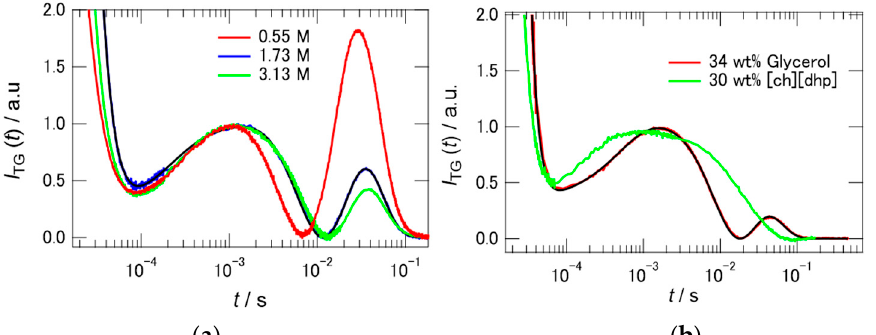
Figure 6. ( a ) TG signals of PYP in corresponding molar concentration of NaCl to 10, 30, 50 wt% [ch][dhp] solution. The q 2 values are 5.49 × 10 11 (0.55 M), 4.16 × 10 11 (1.73 M), and 4.92 × 10 11 (3.13 M) m − 2 . ( b ) Comparison of the TG signals between in the 34 wt% glycerol solution ( q 2 = 6.90 × 10 11 m − 2 ) and in the 30 wt% [ch][dhp] solution ( q 2 = 6.60 × 10 11 m − 2 ) at the similar q values. The signal intensities were normalized relative to the peak at 10 − 3 s both in ( a , b ).